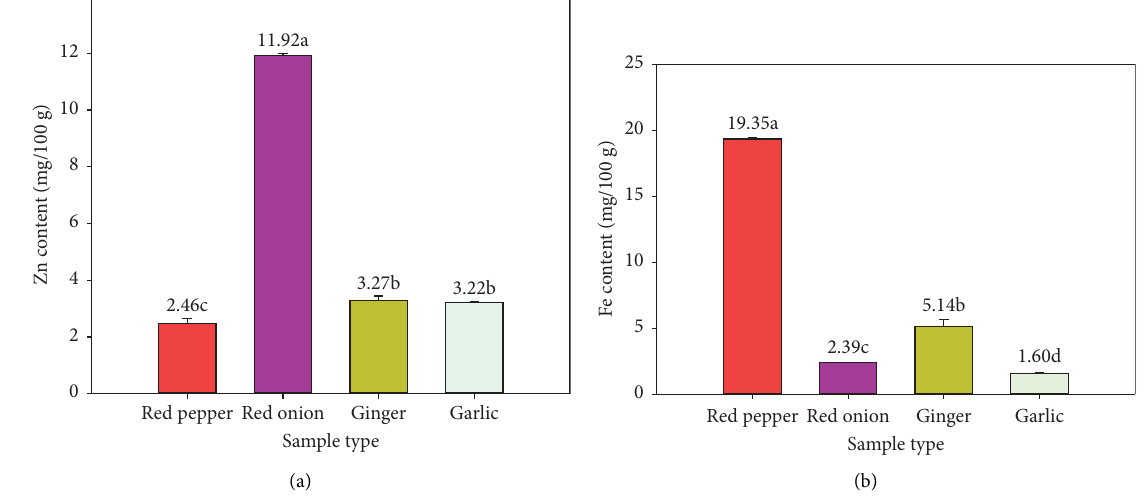
Figure 2: Zinc (a) and iron (b) contents of red pepper, red onion, ginger, and garlic.